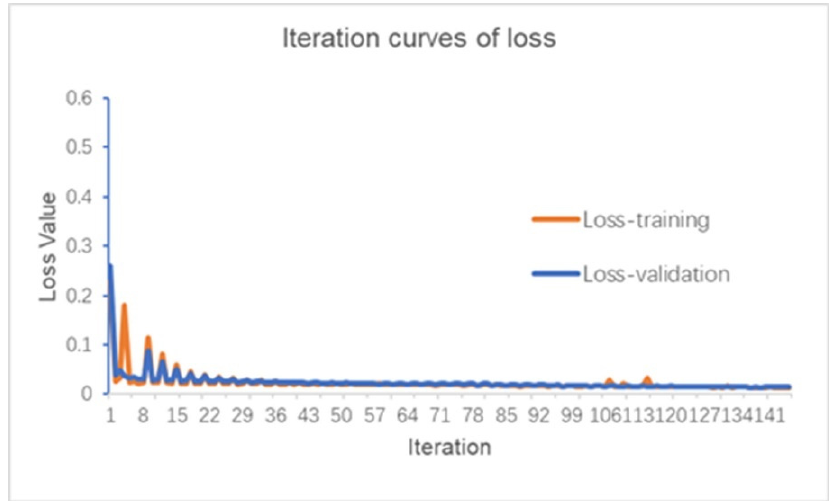
Figure 5. Loss curves of the YOLO V3 model.